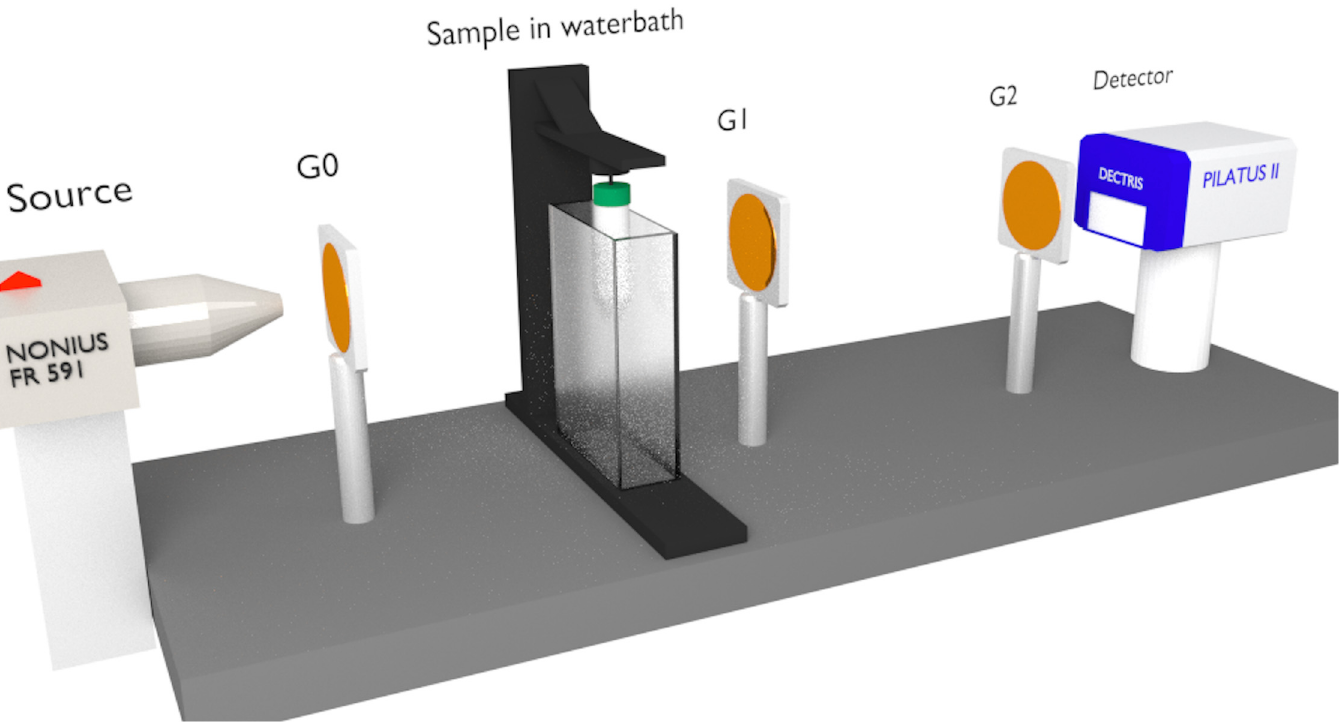
Fig 1. Illustration of the experimental phase-contrast computed tomography system. Three gratings with micrometer-sized structures are installed at a rotating anode X-ray tube (Nonius FR 591). The spatial resolution of the photon-counting X-ray detector (Pilatus II) is (172 × 172) μ m 2 . Two gratings G1 and G2 together resolve the very small refraction angles induced by an object in the beam. Grating G0 (placed directly behind the source) guarantees proper functioning of the grating interferometer when operated under standard laboratory X-ray conditions. The investigated samples were mounted in front of G1 and submerged in a water bath during measurements to avoid image artefacts. The water was cooled to 4°C to decelerate the decay process of the soft tissues.